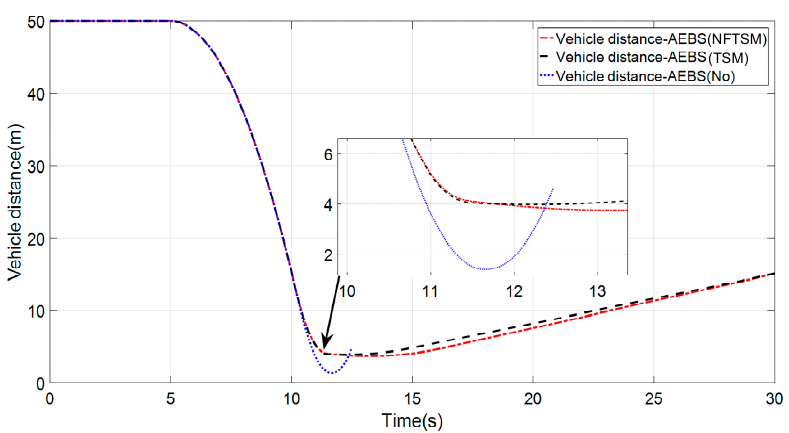
Figure 3. Comparison of relative distance.